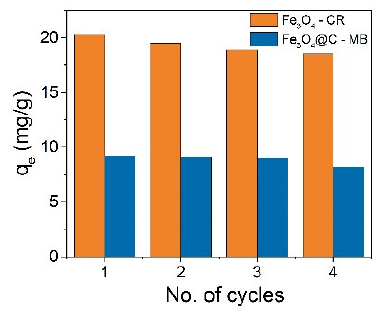
Figure 14. Reusability of Fe 3 O 4 and Fe 3 O 4 @C NPs for adsorption Congo Red (CR) and Methylene Blue (MB), correspondingly. Blue (MB), correspondingly.